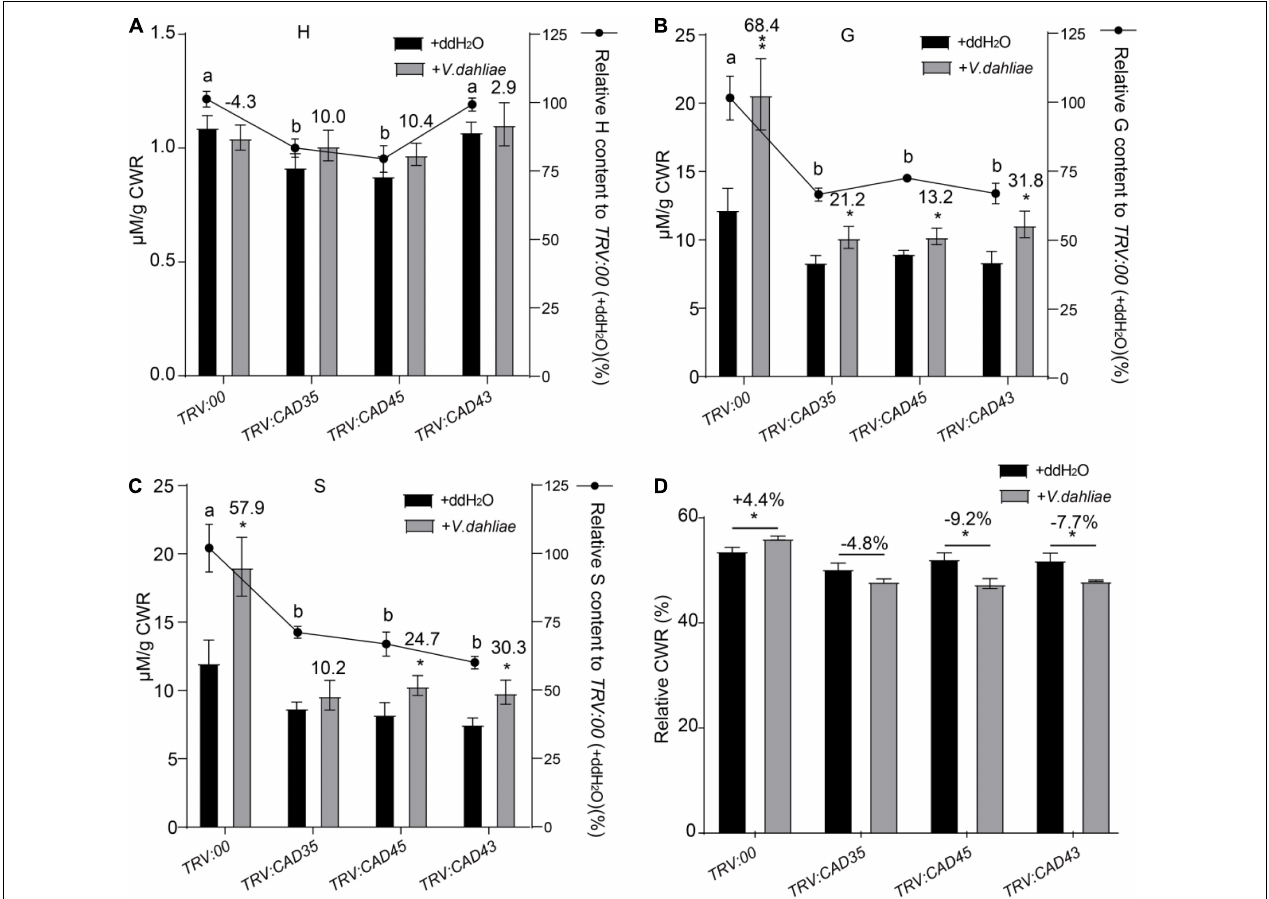
FIGURE 6 | Quantitative analyses of H-, G-, and S-units of lignin in the stem tissues from TRV:00 , TRV:CAD35 , TRV:CAD45 , and TRV:CAD43 VIGS plants under the control (ddH 2 O) and V. dahliae treatment conditions. (A–C) Quantitative analyses of H-, G-, and S-units of lignin in TRV:00 , TRV:CAD35 , TRV:CAD45 , and TRV:CAD43 VIGS plants, respectively. The y axel on the left indicates the contents of individual unit; the y axel on the right indicates the relative content of